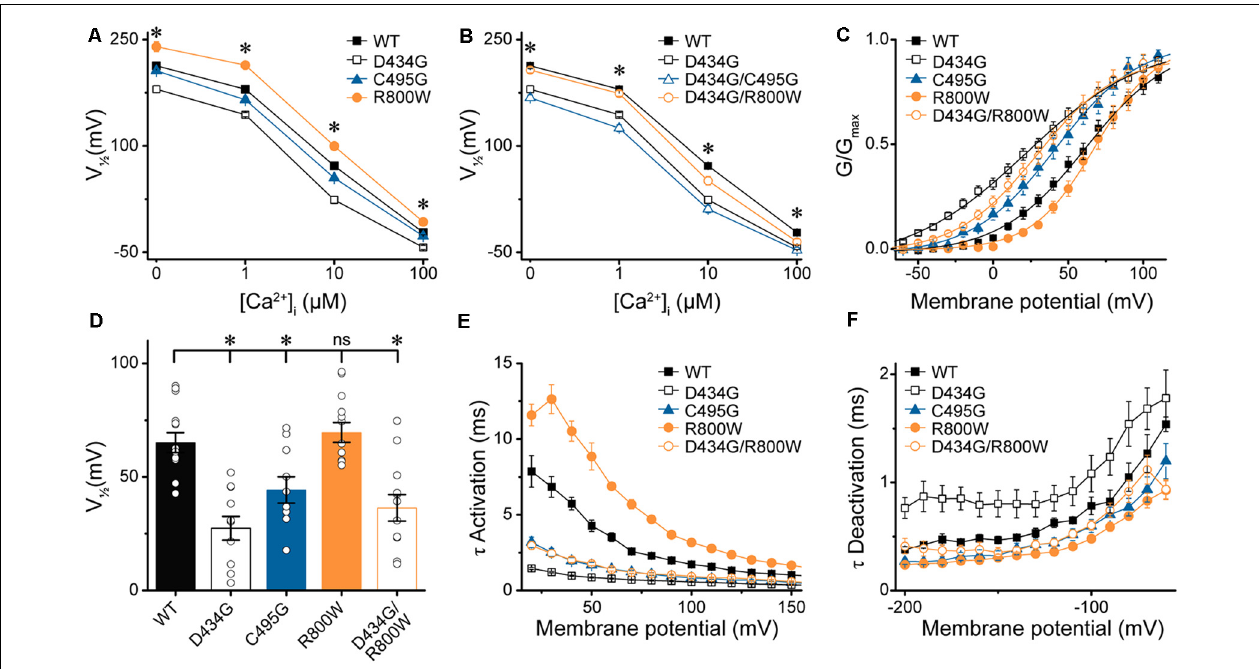
FIGURE 6 | Effects of SNP substitutions in parallel with the D434G mutation on hBK VYR currents. (A,B) V 1 / 2 vs. Ca 2 + relationships for currents evoked from control hBK VYR (WT), D434G, C495G, and R800W channels (A) and channels containing SNPs in parallel with the D434G mutation in the same BK α subunit (B) recorded at 0-, 1-, 10-, and 100- µ M Ca 2 + in symmetrical K + using the same voltage protocols as those in Figure 2 . (C) G–V relationships for BK currents recorded in physiological K + solutions at 10- µ M Ca 2 + for WT, D434G, C495G, R800W, and D434G/R800W channels using the voltage protocols in Supplementary Figures S2A,C . (D) V 1 / 2 values for each construct obtained from the G–V relationships in (C) . (E,F) τ Activation (E) and τ Deactivation (F) for WT and SNP-containing channels in physiological K + . Significant differences in kinetics were observed between WT and SNP-containing channels for activation (D434G, P < 0.0001; C495G, P < 0.0001; R800W, P < 0.0001; D434G/R800W, P < 0.0001) and deactivation (D434G, P = 0.01; C495G, P = 0.02; R800W, P = 0.0006). ∗ P < 0.05, one-way ANOVA with Bonferroni post hoc test for significant differences in V 1 / 2 values between all constructs at each Ca 2 + concentration (A,B) .